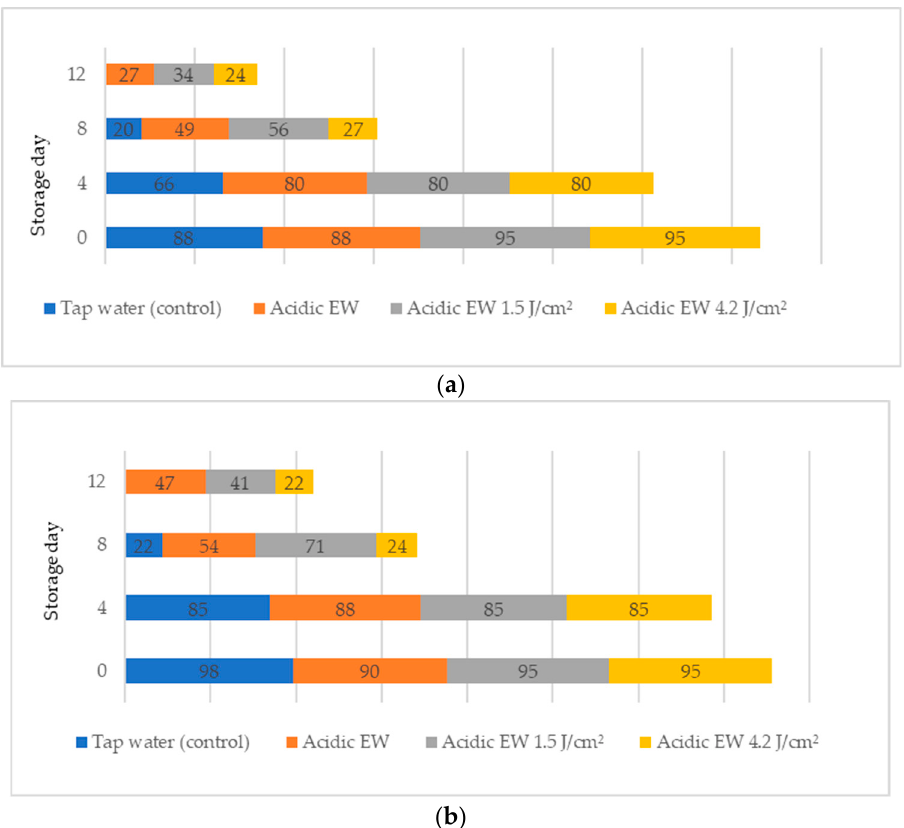
Figure 2. The sensory evaluation score on yes percentages (%) of fresh-cut pennywort leaves ( a ) question 1 and ( b ) question 2.